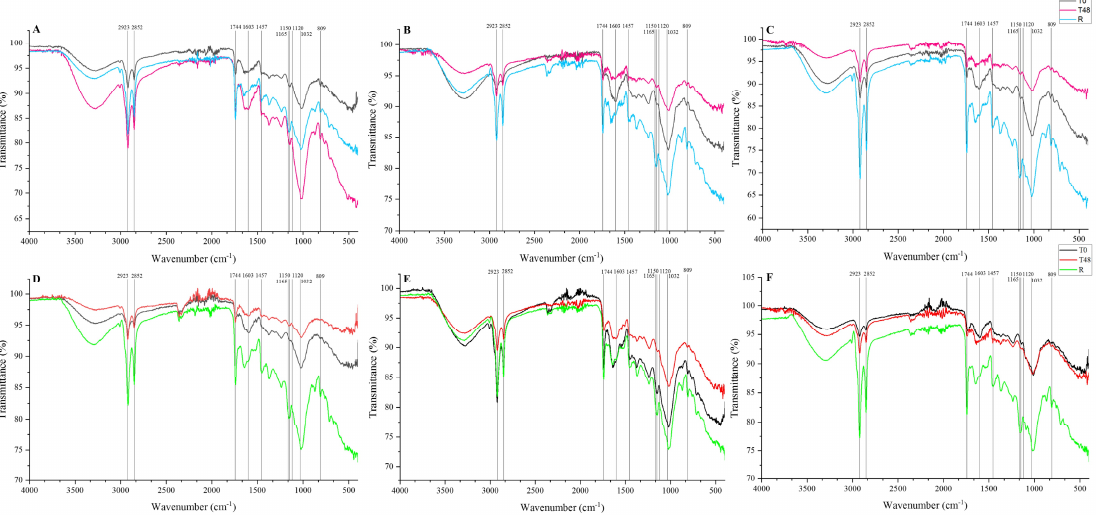
Figure 5. FTIR profile of each altitude and processing. N process: ( A ) (800 m), ( B ) (1200 m), and ( C ) (1400 m), PN process: ( D ) (800 m), ( E ) (1200 m), and ( F ) (1400